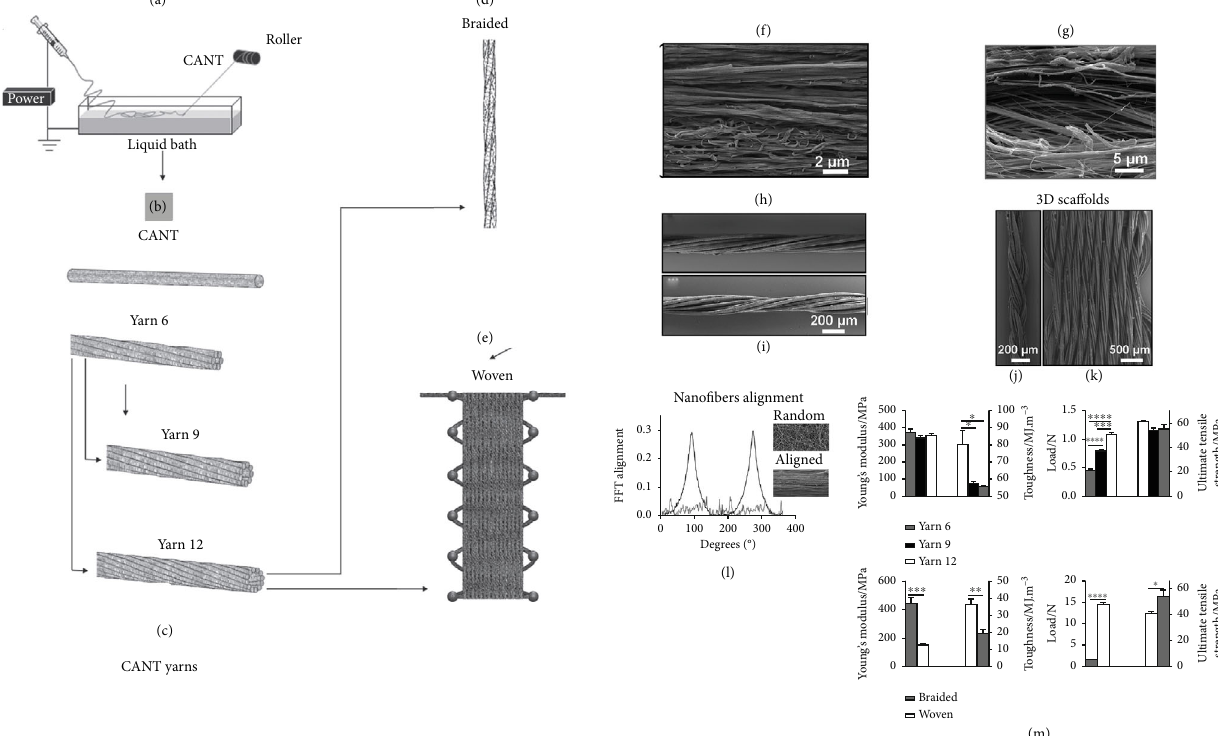
Figure 4: Hierarchical assembly of CANT: (a) electrospinning system, (b) elementary unit of 3D assembly, (c) yarn composed of twisted CANT, (d) braided 3D sca ff old, (e) woven 3D sca ff old, (f, g) SEM images of CANT observed at 0.02 ms -1 , (h, i) SEM images of yarn, (j) braided 3D sca ff old, (k) woven 3D sca ff old, (l) degree of nano fi ber alignment in CANT and random mess, (m) tensile properties of yarn 6, 9, 12, and 12, and (o, p) tensile properties of braided and woven 3D sca ff olds. Reproduced with permission from reference